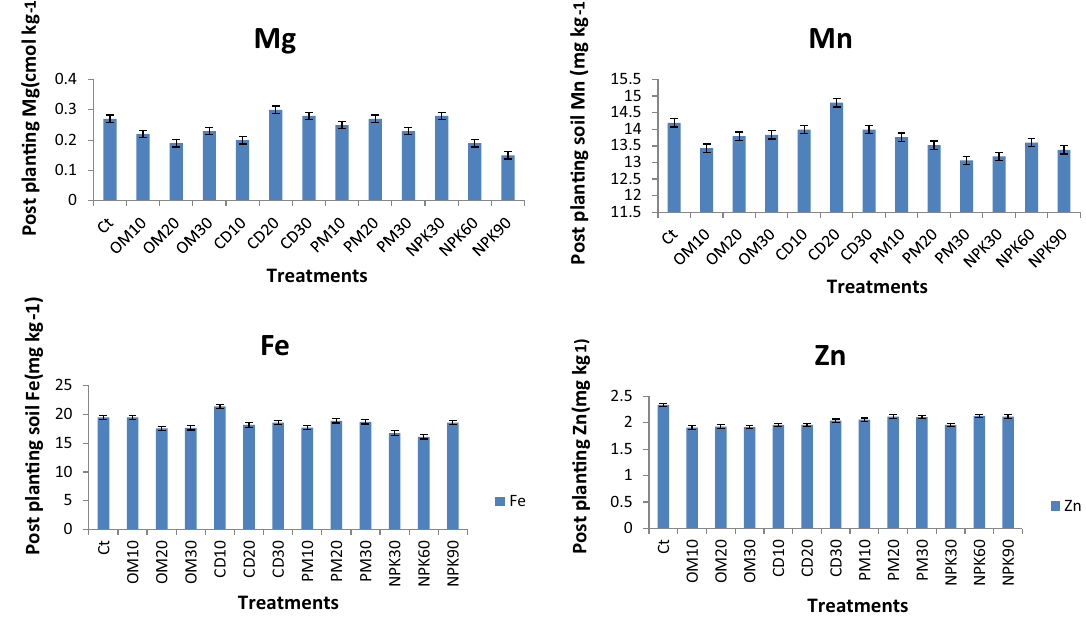
Fig. 2 Effect of different sources and rates of NPK and organic fertilizers on post-planting soil properties of Moringa